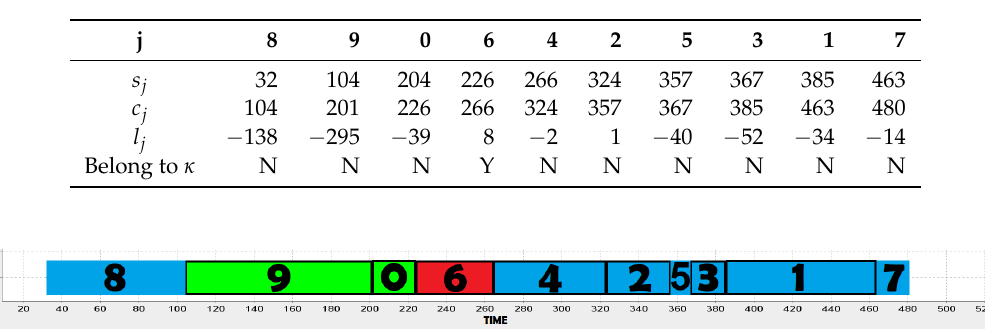
Figure 5. ED-schedule σ 1 in which kernel K ( σ ) is